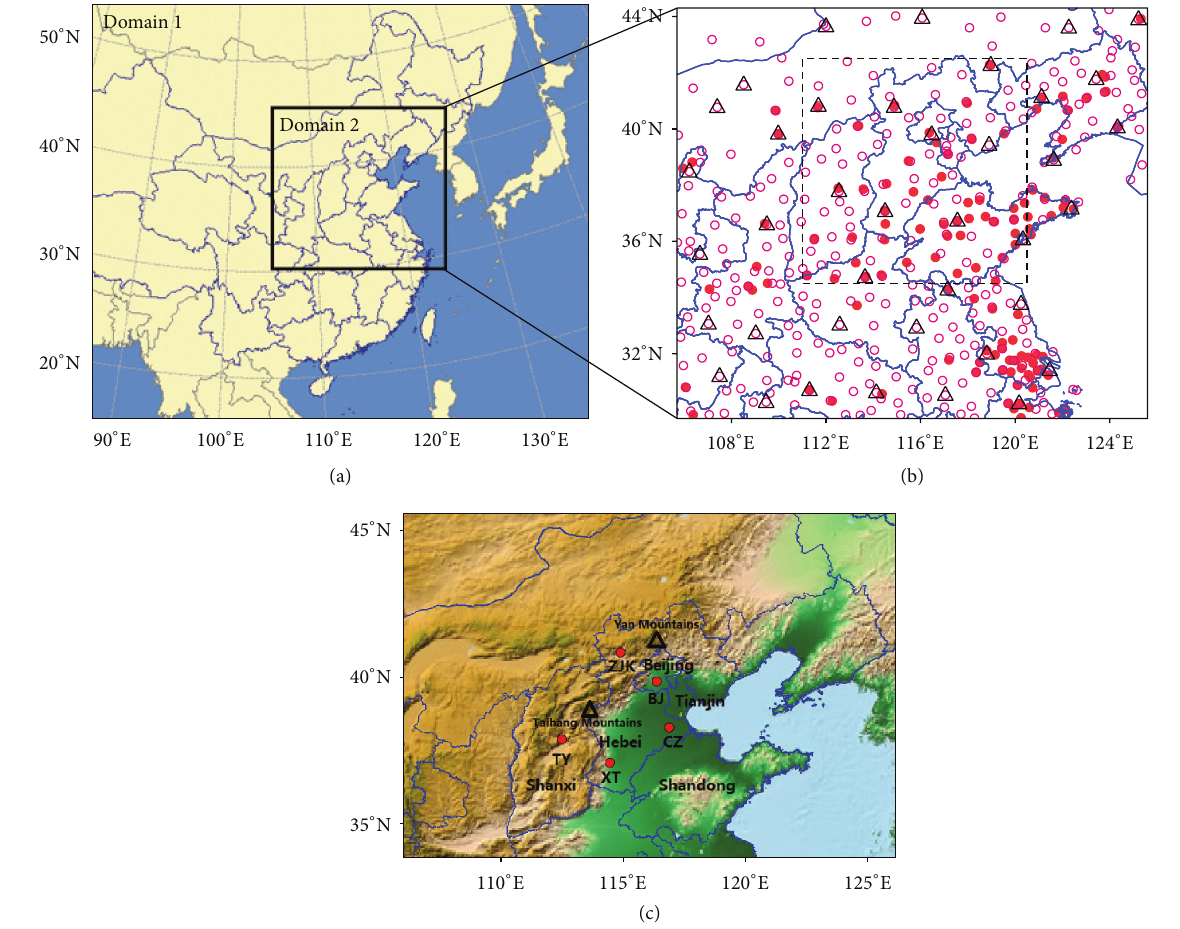
Figure 1: Nested modeling domains (a), the distribution of observation sites within domain 2 ((b) filled circles: PM 2.5 observation sites; open circles: surface meteorological sites; open triangles: upper-air meteorological stations; the dashed-line square area represents the research area (3JNS)), and the topography of the research area